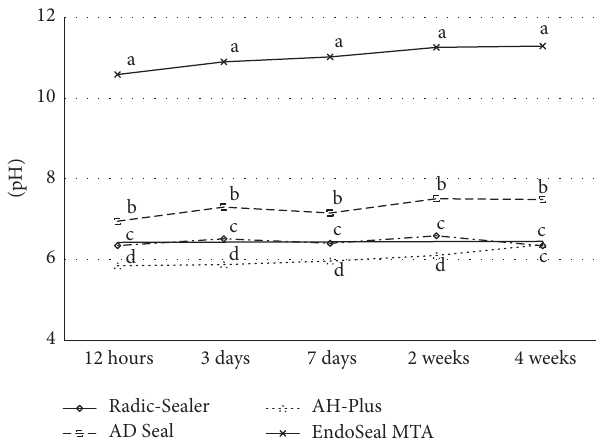
Figure 6: pH change of set samples during 4 weeks. a , b , c , d Different letters present significant difference between four sealers at the same test time periods ( 𝑃 < 0.05